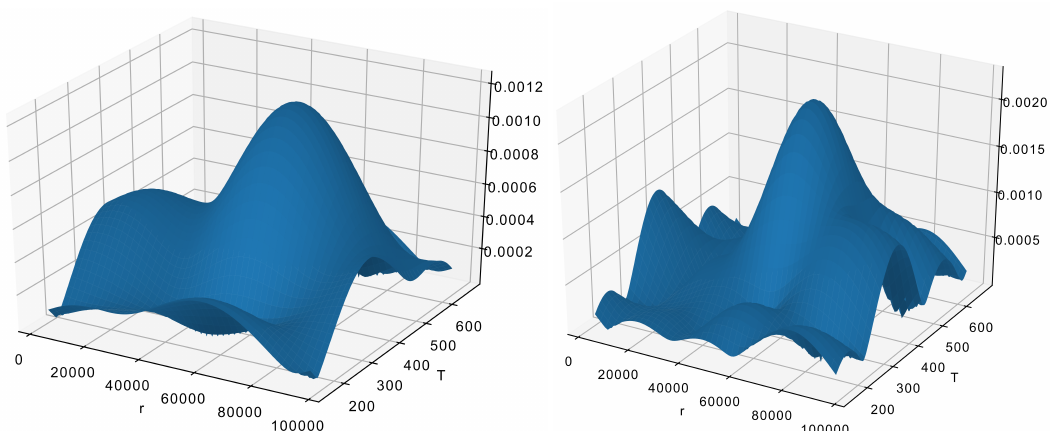
Figure 5. Insufficient amount of Fourier-transformed data, the result is too smooth (2 × 2 in the left , 4 × 4 in the right ).